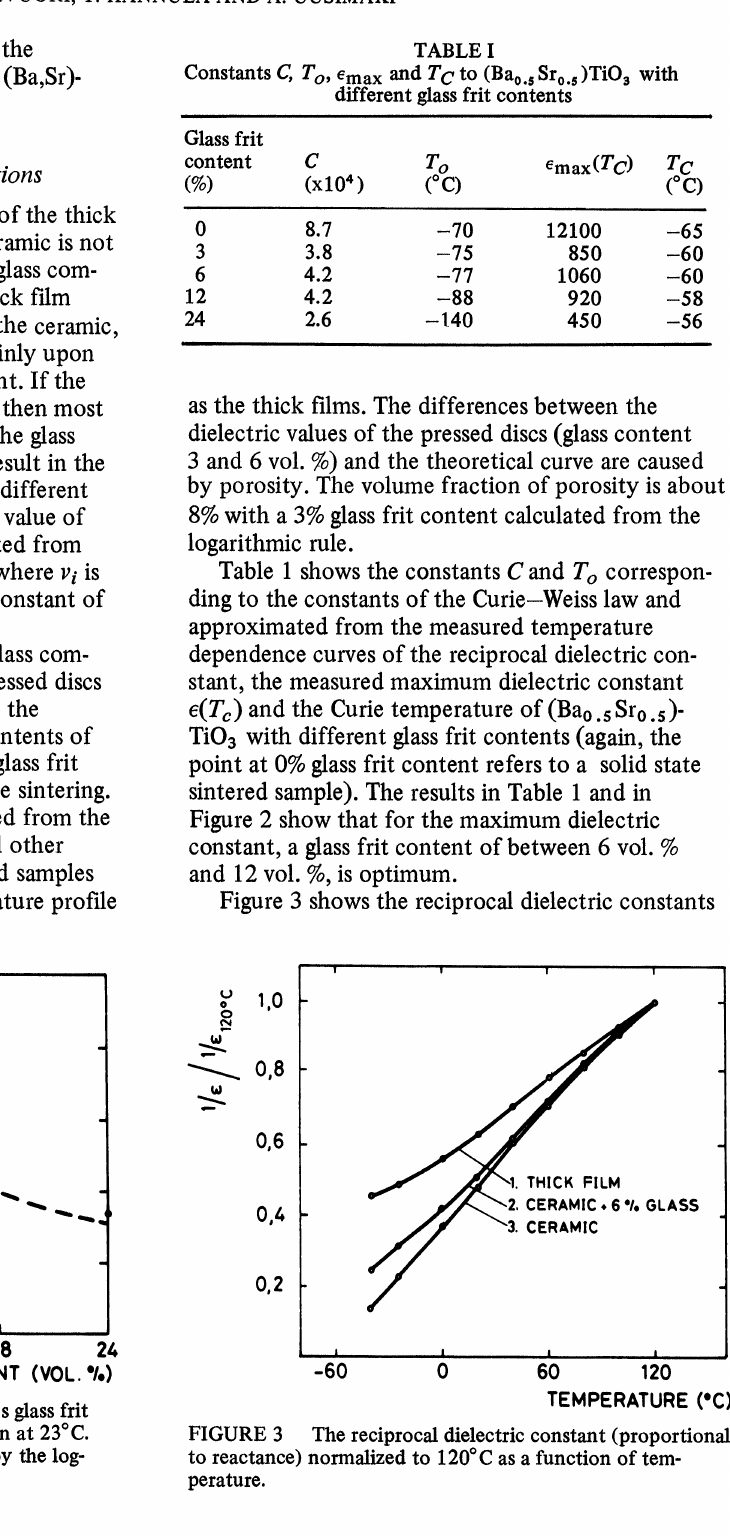
The reciprocal dielectric constant (proportional to reactance) normalized to 120C as a function of tem-